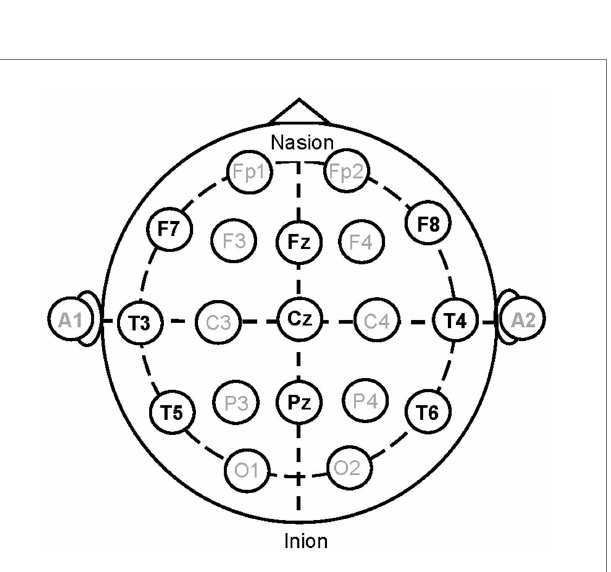
FIGURE 6 Electrode positions where EEG was